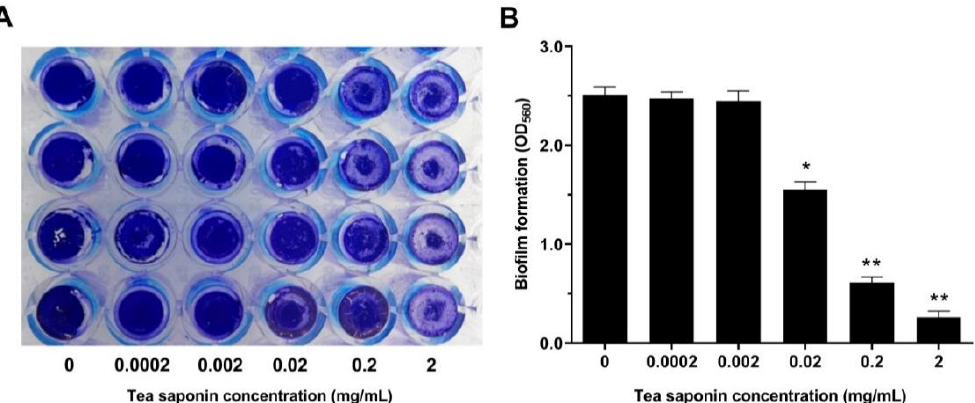
Figure 2. Effects of TS on GBS2 biofilm. ( A ) The crystal-violet stained biofilms of GBS2 in the 96-well plates. ( B ) Results of the biofilm biomass measured by using a microplate reader at a wavelength of 560 nm. Every data point was obtained by averaging the absorbance data from at least four replicate wells (* represents p < 0.05 and ** represents p < 0.01).